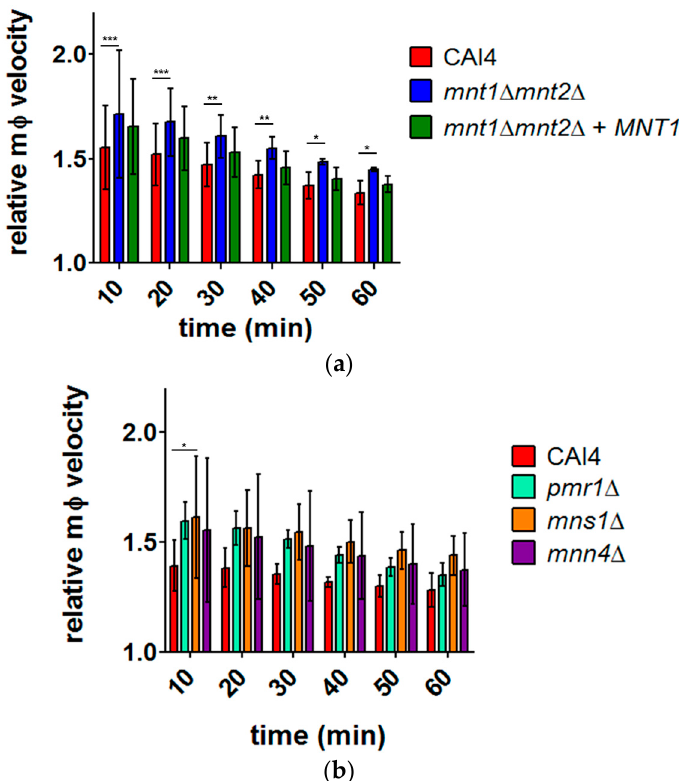
Figure 2. Quantitative analysis of macrophage migration towards wildtype and glycosylation C. albicans mutants. The charts show mean relative macrophage velocity (relative to macrophage velocity without Candida ) + SD of J774.1 macrophages when cultured with: ( a ) CAI4, mnt1 Δ mnt2 Δ , and mnt1 Δ mnt2 Δ + MNT1 ; and ( b ) CAI4, pmr1 Δ , mns1 Δ , and mnn4 Δ at 10 min intervals during the 1 h observation period. Statistical significance was evaluated using two-way analysis of variance (ANOVA) and Bonferroni Multiple Analysis Comparison Tests. * p < 0.05; ** p < 0.01; *** p < 0.001; 50 macrophages analysed from independent experiments ( n = 3). All of the values were significantly different from the normalised average velocity.